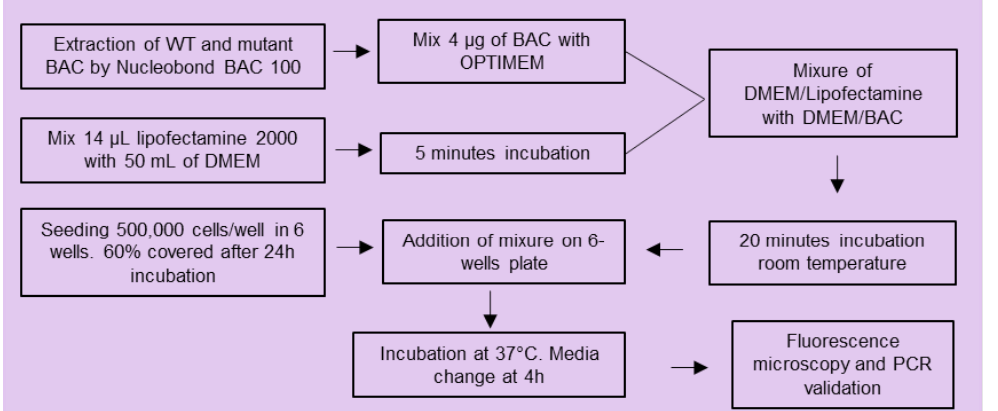
Figure 3. Workflow representation of the methodology for the recombination system including the experimental